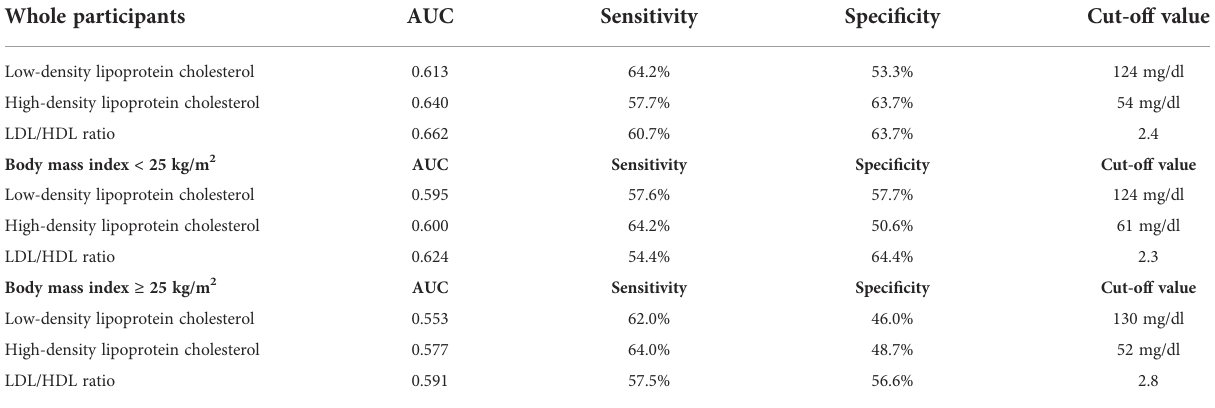
TABLE 3 The area under the curve and optimal cut-off